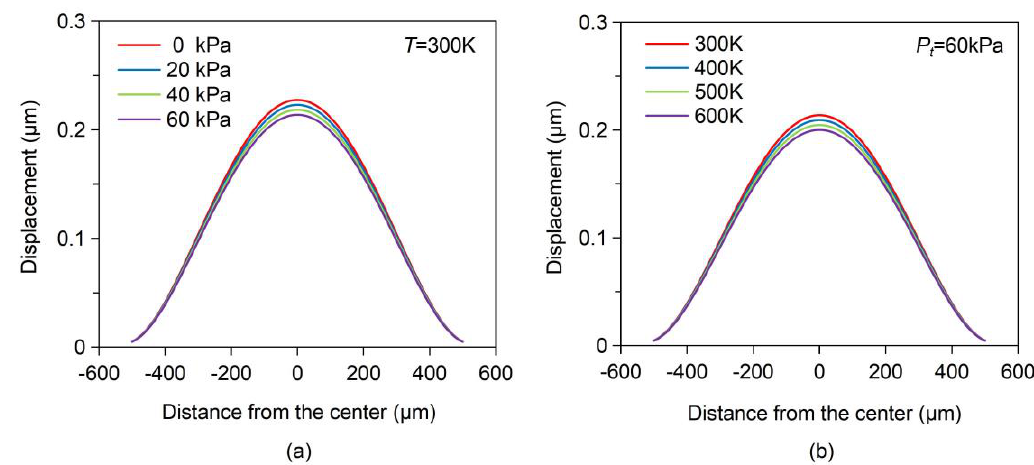
Figure 2. ( a ) Variation in diaphragm deformation with pressure inside the cavity. ( b ) Variation in diaphragm deformation with ambient temperature.